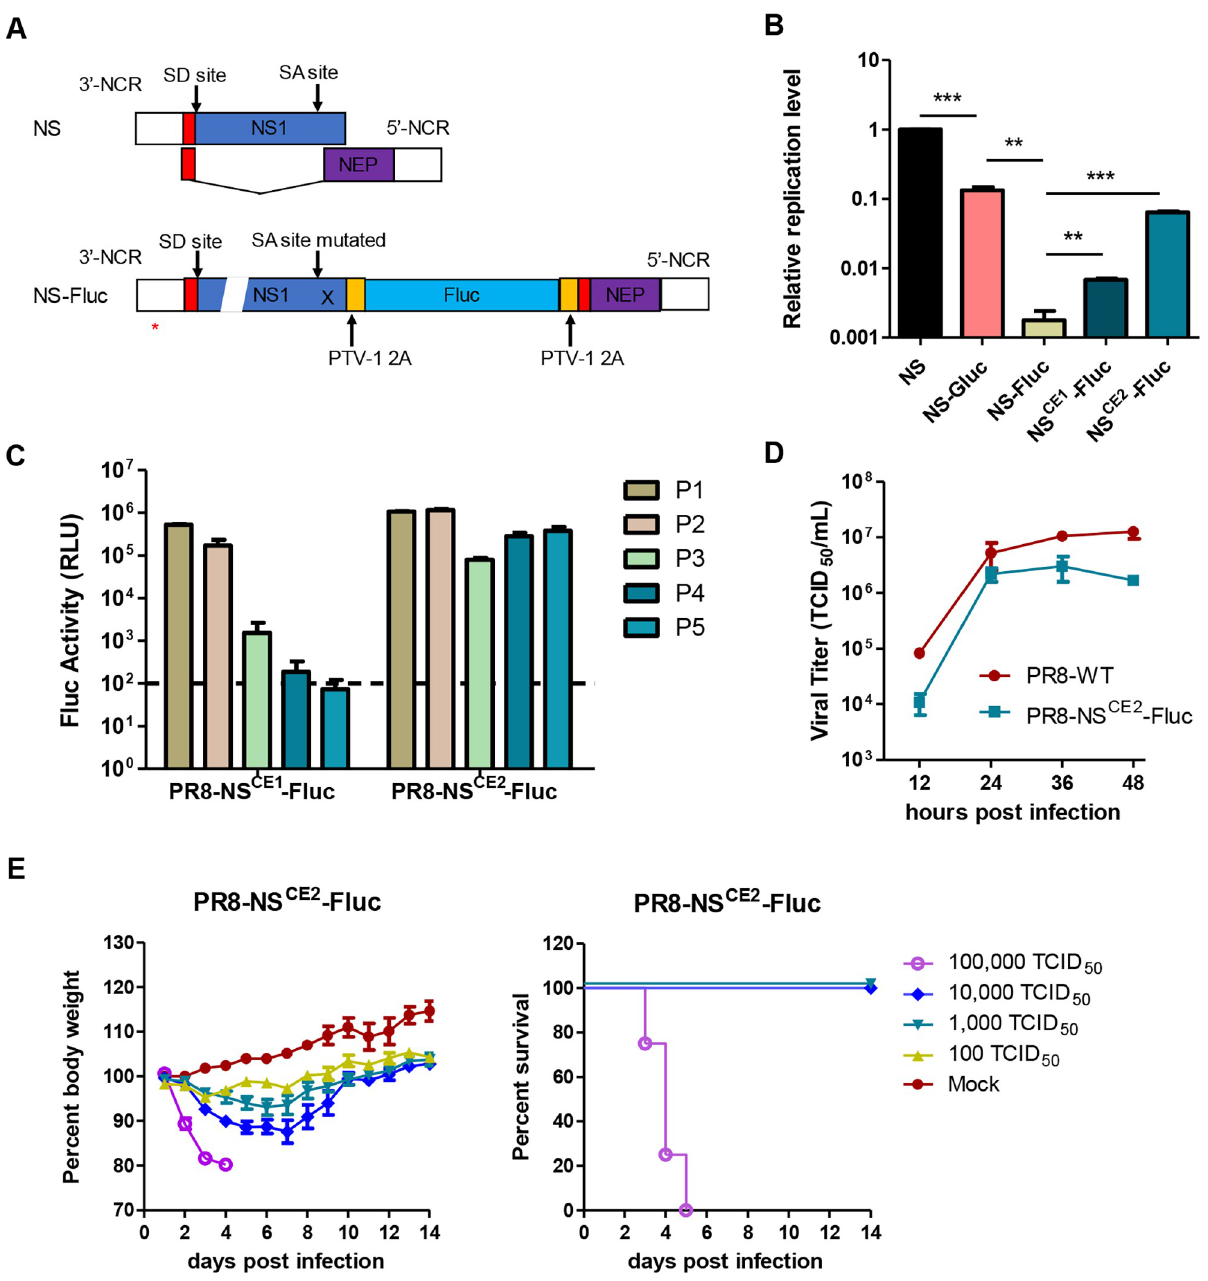
Fig 4. Generation and characterization of a recombinant IAV expressing Fluc gene. (A) Schematic representation of the natural NS segment and modified NS encoding the Fluc reporter gene. SD/SA—Splice donor/acceptor sites. (B) Relative replication efficacies of NS-derived vRNAs normalized to M. (C) MDCK cells were infected with PR8-NS CE1 -Fluc or PR8-NS CE2 -FLuc viruses from serial passage experiments in eggs (passages 1 to 5) at an MOI of 0.01. At 24 h.p.i. cells were harvested, and luciferase assays were performed. (D) Comparation of the in vitro replication kinetics of PR8-WT and reporter PR8-NS CE2 -Fluc viruses. (E) PR8-NS CE2 -Fluc infection induces severe body weight loss and lethal disease in mice.